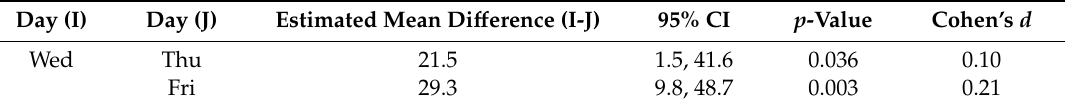
Table A3. Pairwise comparisons of significant estimated mean di ff erences in SB (min) between weekdays A .